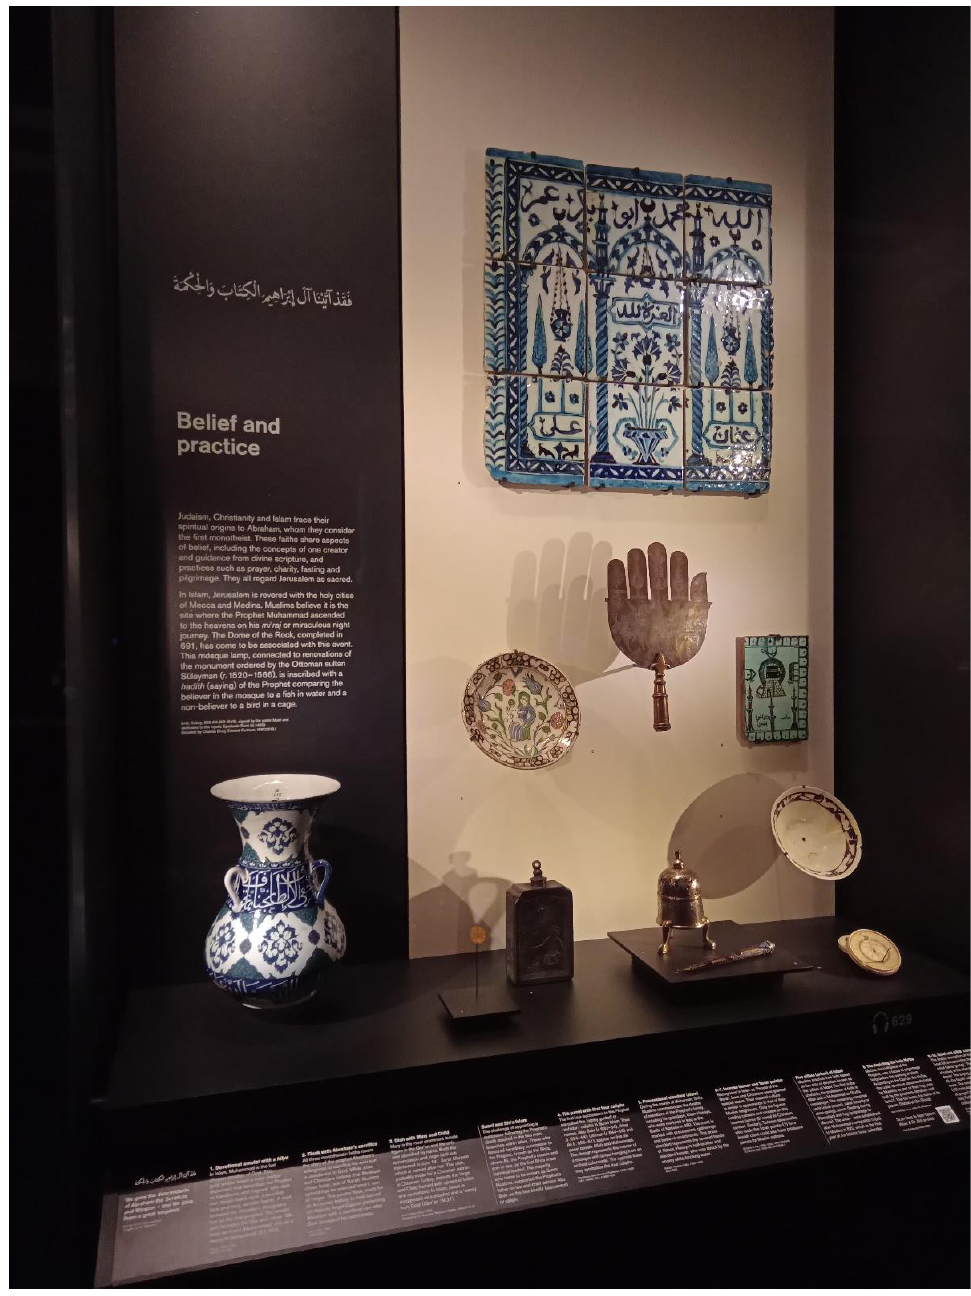
Figure 14. View of the showcasing box “Belief and Piety” in the Albukhary Gallery, British Museum. Photos of the author.